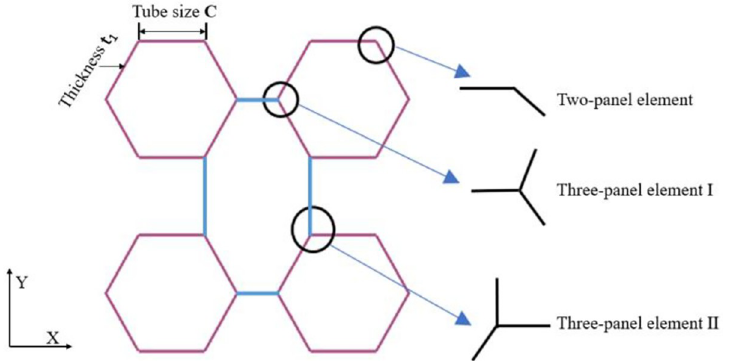
Fig 2. Cross-sectional shape of the five-cell tube and typical angle